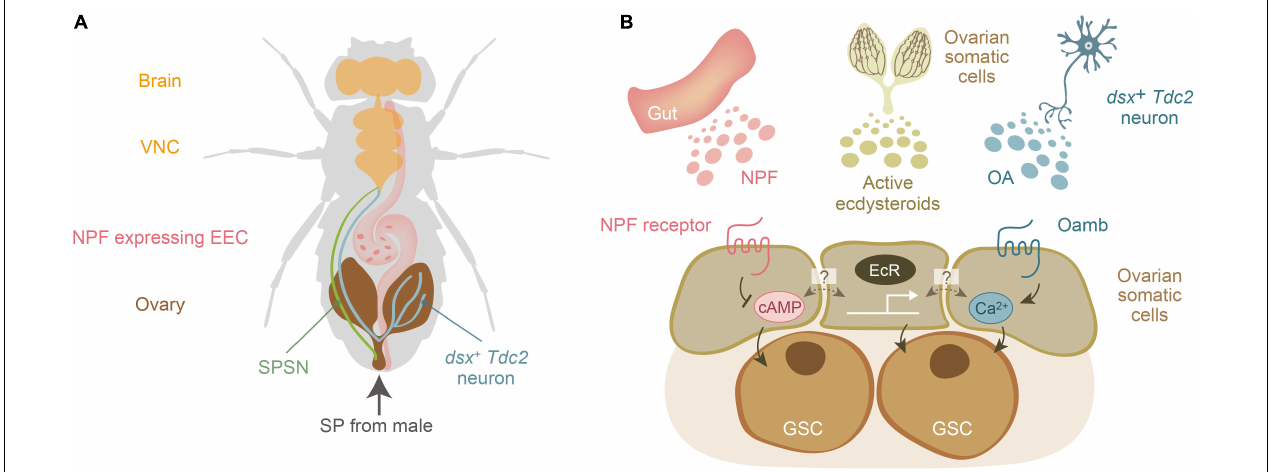
FIGURE 2 | Three humoral factors essential for mating-induced increase in female germline stem cells of Drosophila melanogaster . (A) A schematic representation of the anatomical position of the brain, ventral nerve chord (VNC), sex peptide receptor-positive sensory neuron (SPSNs), the ovary-projecting dsx + Tdc2 neuron, the ovary, and the NPF-expressing enteroendocrine cell (EEC). Sex peptide (SP) from male seminal fluid is transferred to the female uterus. (B) Three humoral factors, ecdysteroids, neuropeptide F (NPF), and octopamine (OA), are released from the gut, ovary, and a subset of octopaminergic neurons ( dsx + Tdc2 neurons), respectively. The dark colored lines in the ovary represents the ovarian somatic cells, which are the source of ovarian ecdysteroids. Active ecdysteroids (such as 20-hydroxyecdysone) are received by the nuclear receptors EcR. On the other hand, NPF and OA are received by their specific receptors belonging to the G-protein coupled receptor family. The second messengers for the NPF receptor and octopamine receptor (Oamb) are cAMP and Ca 2 + , respectively. Of note, it is currently unclear whether EcR, NPF receptor, and Oamb are expressed in the same ovarian somatic cells or whether each of them is expressed in distinct cell types of the ovarian somatic